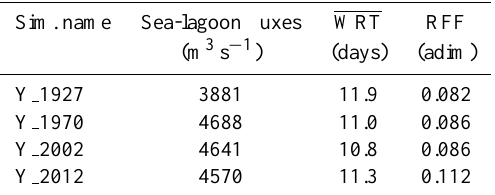
Table 3. Simulation results for the 1927–2012 scenarios. Results are given in terms of average sea-lagoon water fluxes, basin-wide average water renewal time and return flow factor. The last two pa- rameters were calculated as average of four